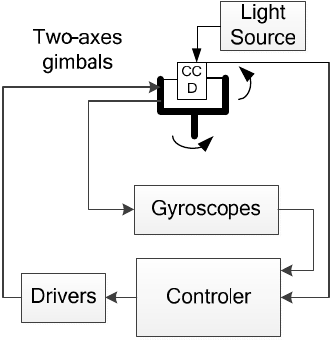
Figure 1. Configuration of the tracking control system.